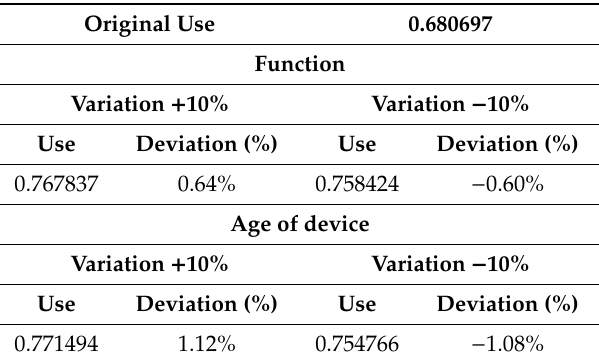
Table 29. Sensitivity analysis for neonatal